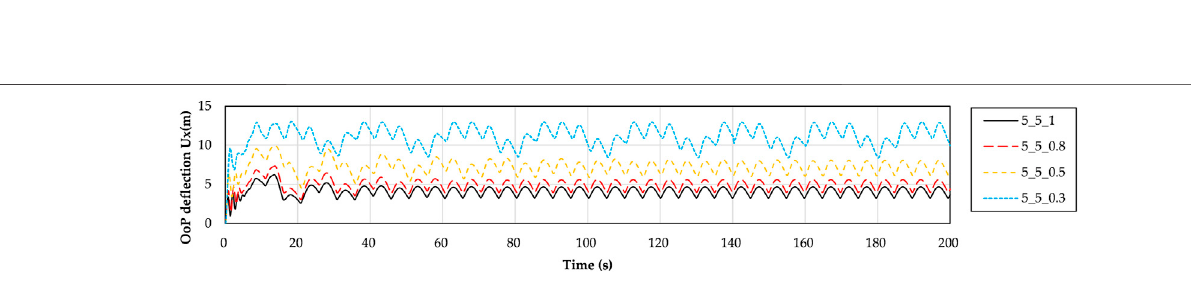
FIGURE 3 | Comparison of effects of fl ap-wise stiffness on power and pitch angle.